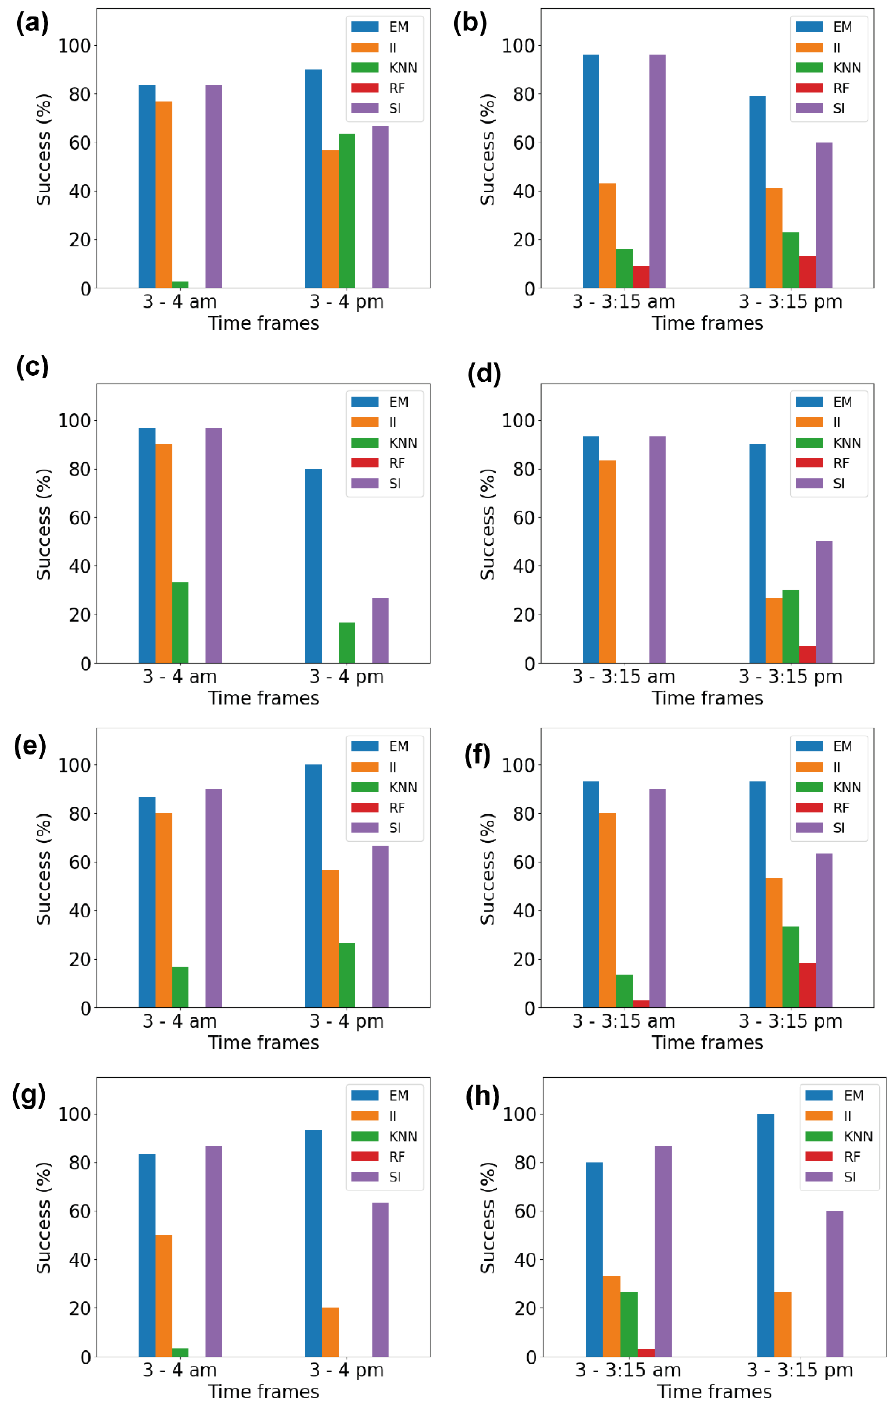
Figure 5. The success rates of each imputation method: ( a , b ) show the success rates for volunteer V1, ( c , d ) show the success rates for volunteer V2, ( e , f ) show the success rates for volunteer V3, and ( g , h ) show the success rates for volunteer V4.